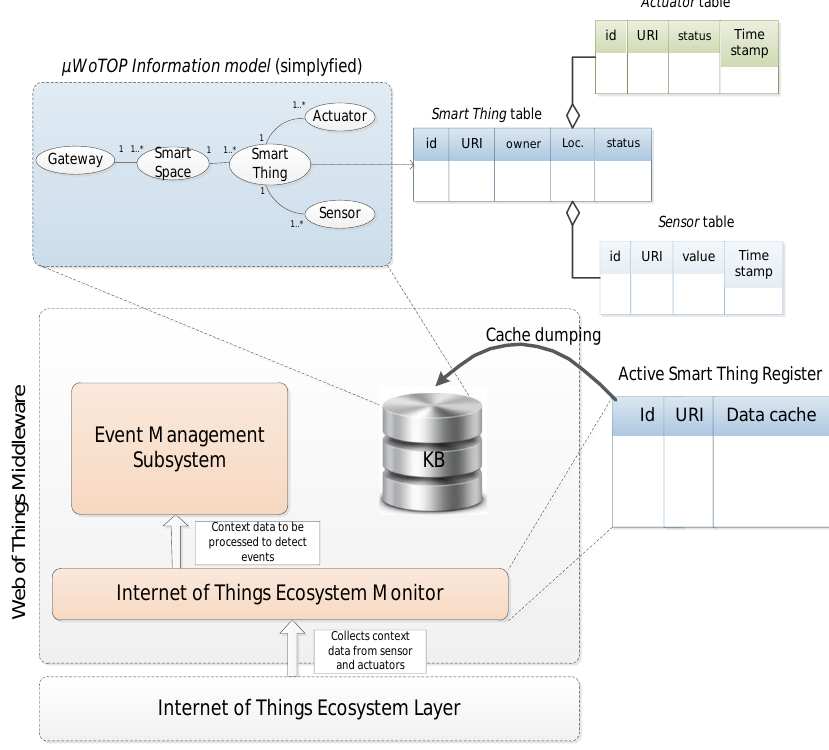
Figure 2. Procedure for collecting context information data generated in the Internet of Things Ecosystem